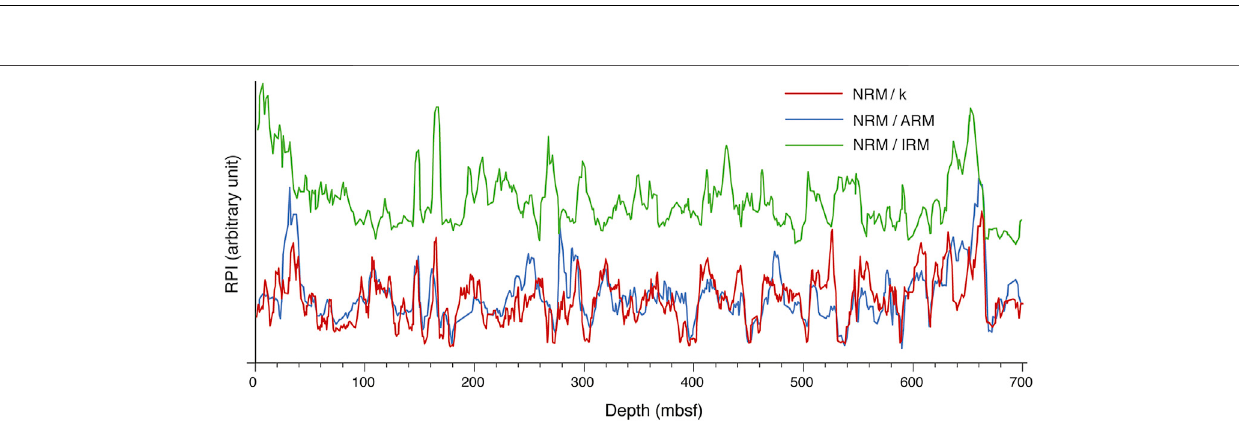
Frontiers in Earth Science |